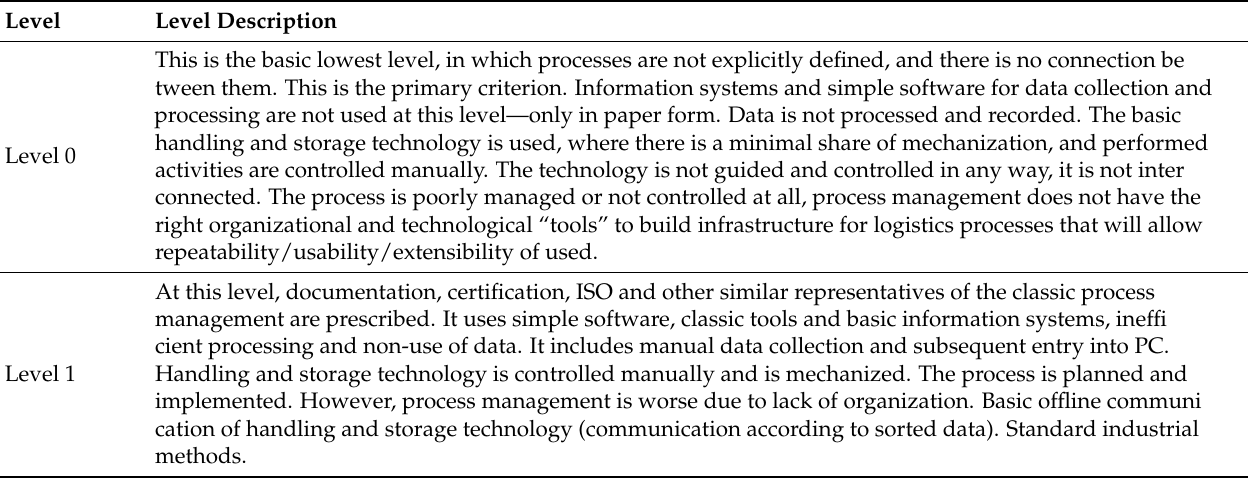
Table A1. Description of the required levels for